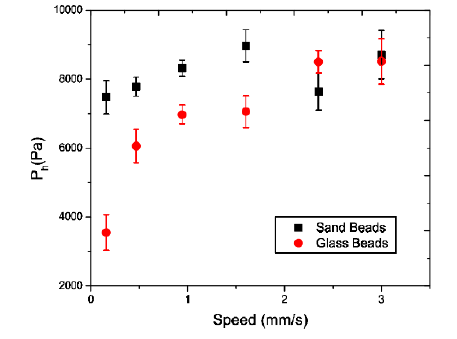
Fig. 6. Penetration hardness vs. speed of the cone for wet sand (black Solid Square) and wet glass beads (red solid circle). Silicone oil has the higher viscosity in comparison with water, see Table1, so at higher penetration speeds, the hardness of the glass beads and silicone oil assembly displays velocity